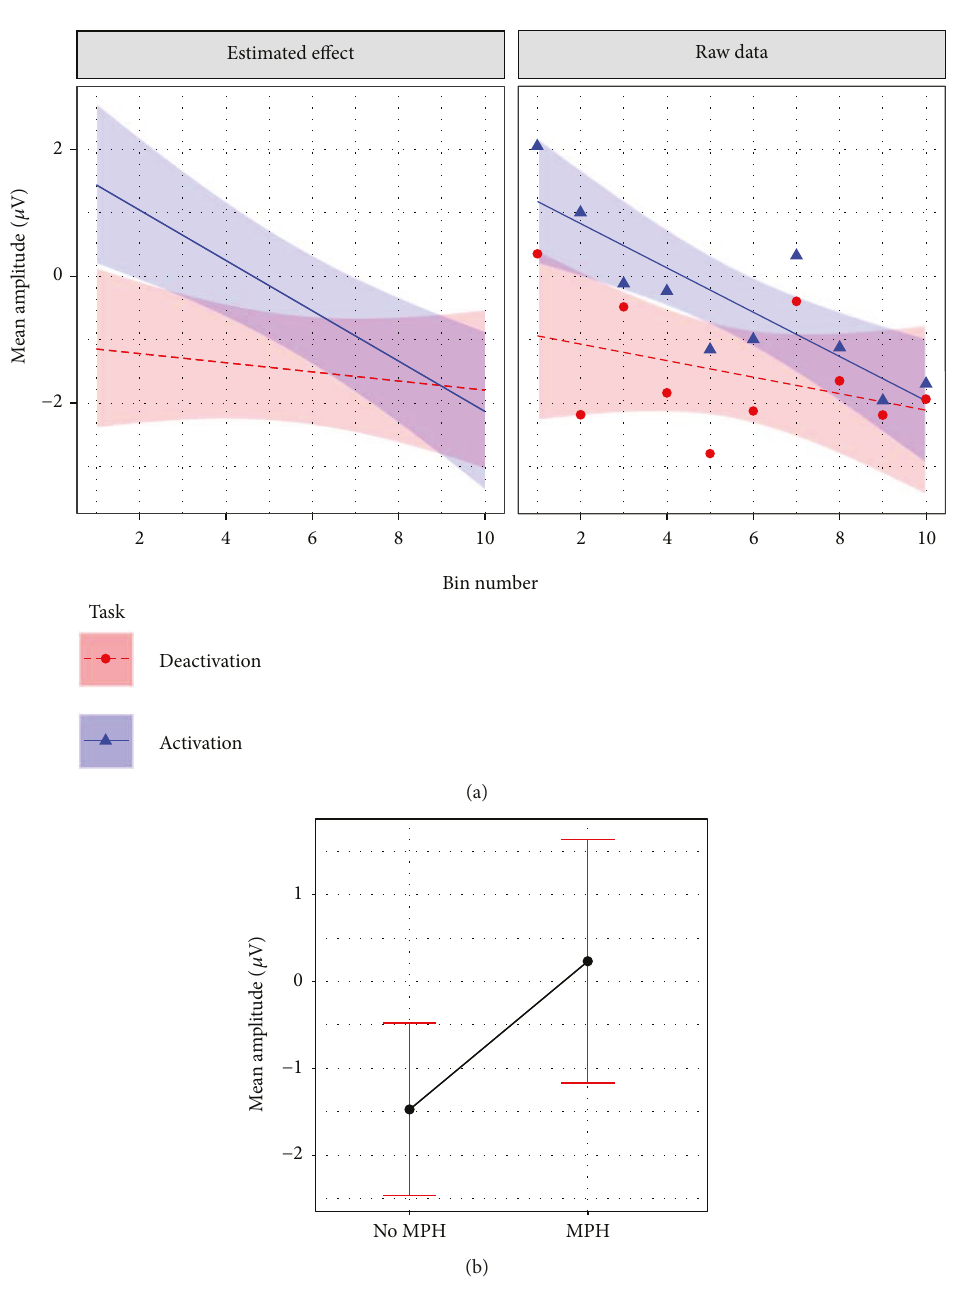
Figure 6: Visualization of e ff ects moderating within-session NF learning in the transfer condition. (a) Interaction e ff ect between bin number and task. Transfer condition: no continuous feedback stimulus visible. Task. Deactivation: generation of positive potential shifts. Activation: generation of negative potential shifts. (b) MPH e ff ect plot. MPH: being on constant methylphenidate